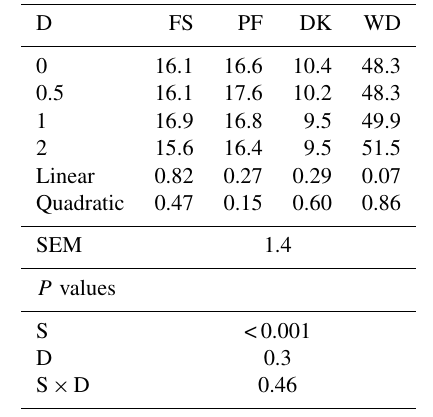
Table 2. Effect of the dose of EFE (mg(gDM) − 1 ) on the soluble organic matter after 12h of pre-incubation of date palm by-products